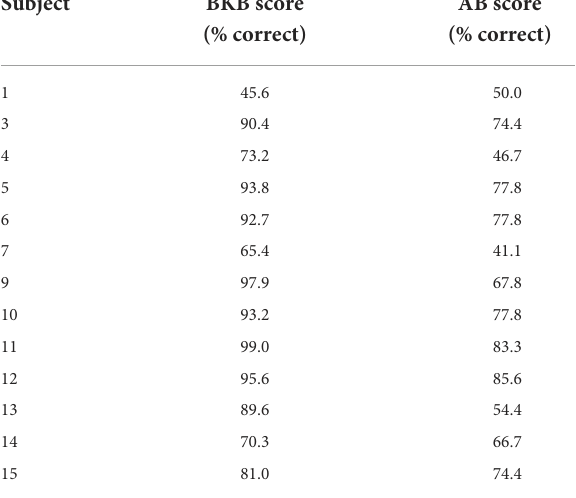
TABLE 2 Mean speech test scores ( N =